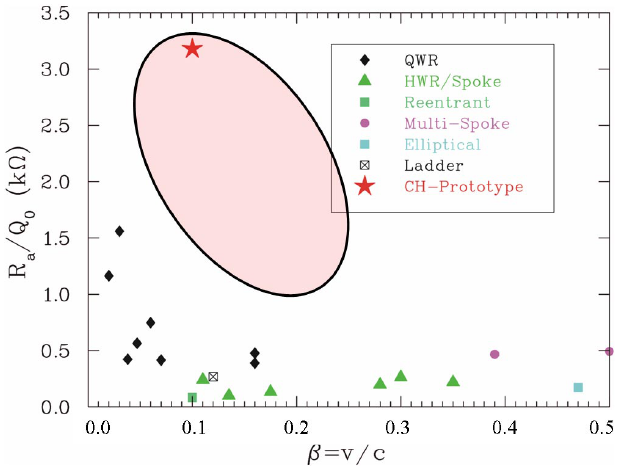
R per cell as a function of (cid:1) . See the legend a s